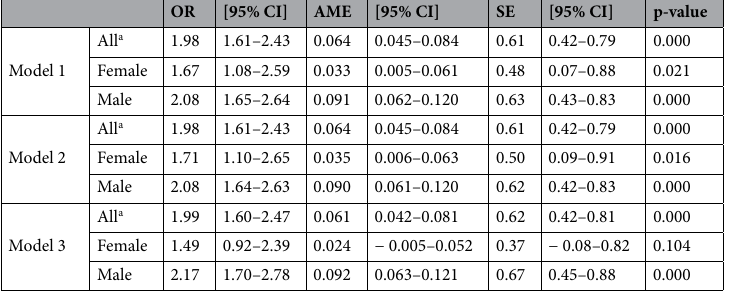
Table 3. The relationship of childhood hearing loss to childlessness. OR Odds ratio, AME average marginal effect (average change in probability of being childless), SE Semi-elasticity (proportional change in probability of being childless). Model 1—adjusted for age. Model 2—adjusted for age, mother and father’s education. Model 3—adjusted for age, mother and father’s education and self-reported health, systolic and diastolic blood pressure, motor, visual, somatic and mental impairment, and smoking. a Also adjusted for sex.